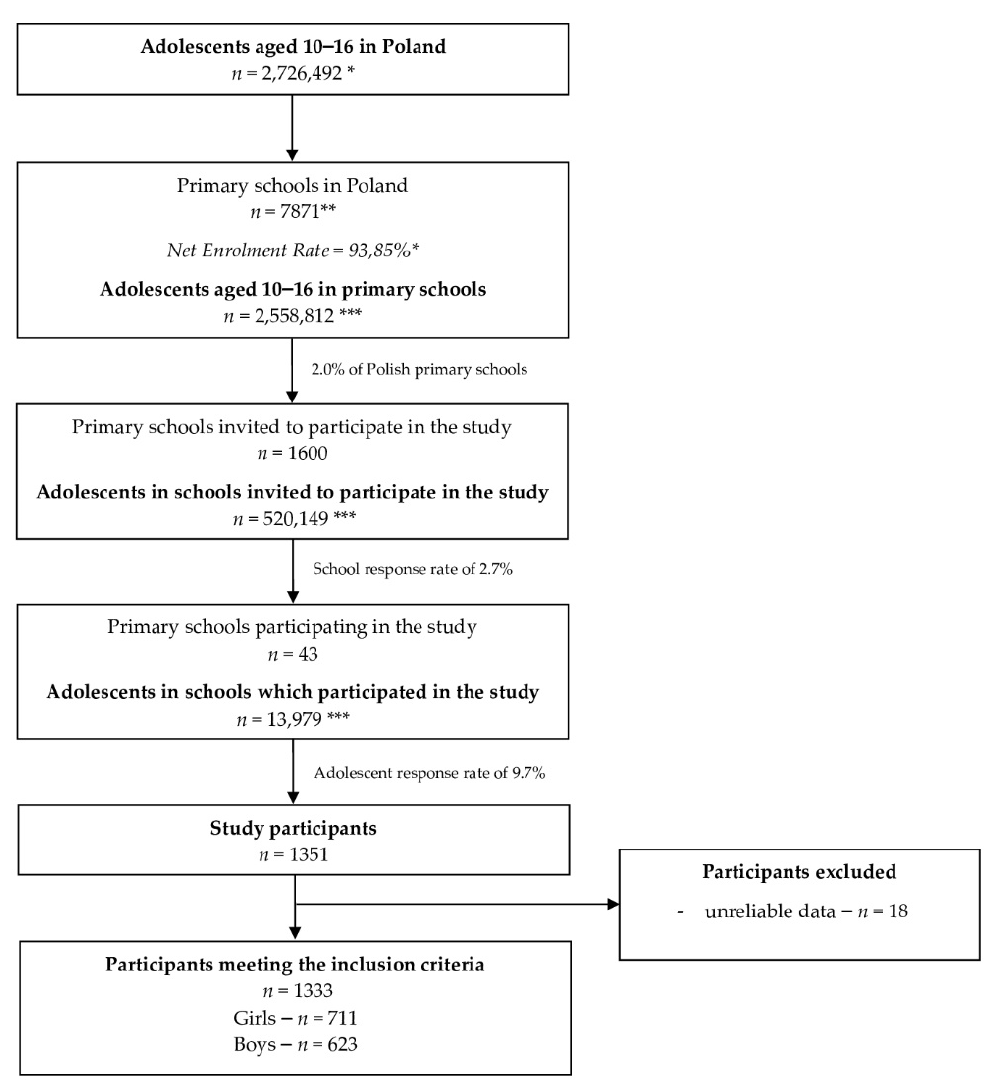
Figure 1. The recruitment procedure on flow chart for the adolescents from the Diet and Activity of Youth during COVID-19 (DAY-19) Study cohort ( n = 1333); * [47,48] ** [49] *** calculated based on data of the Central Statistical Office.